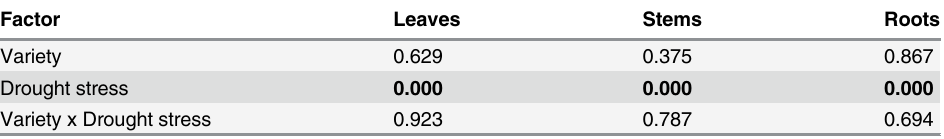
Table 6. Two-Way ANOVA on dry biomass (g) of leaves, stems, and roots, of non-stressed and drought stressed plants at the end of the drought treatment in the growth chamber experiment. Factor Leaves Stems Roots Variety Drought stress 0.000 Variety x Drought stress Signi fi cant (p < 0.05) factors are marked in